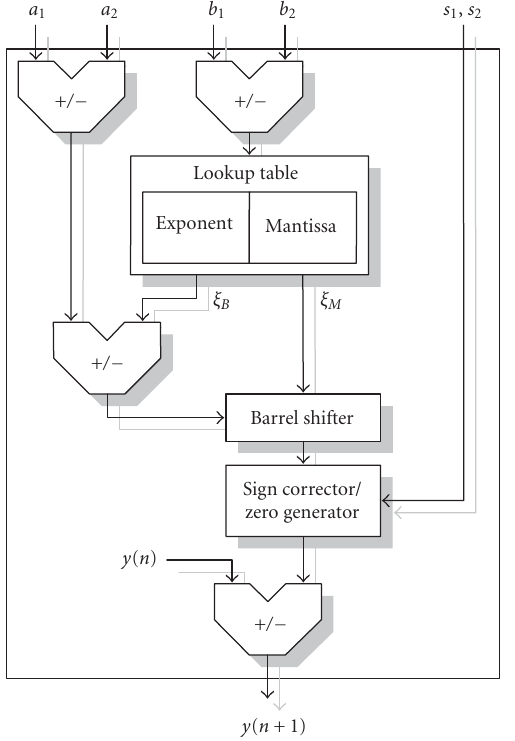
Figure 1: Single-digit 2DLNS inner product computation